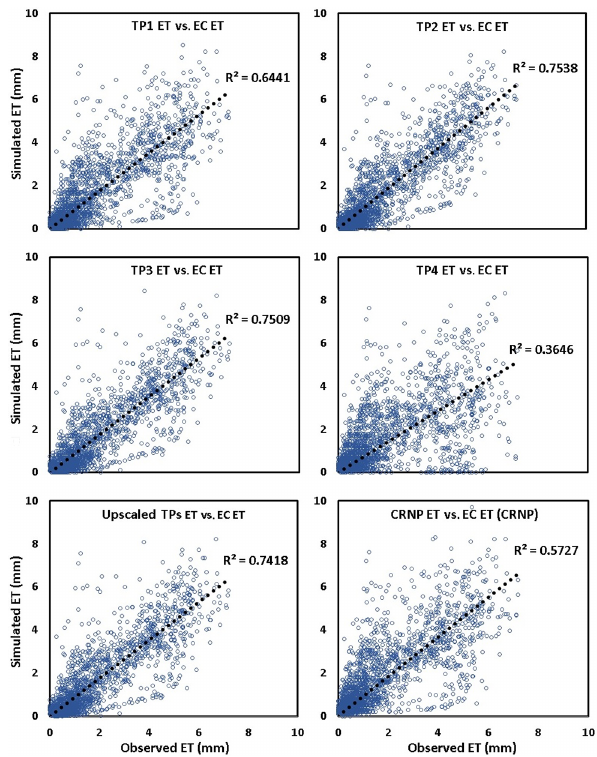
Figure 9. Simulated daily ET a versus observed daily ET a in differ- ent locations at the study site